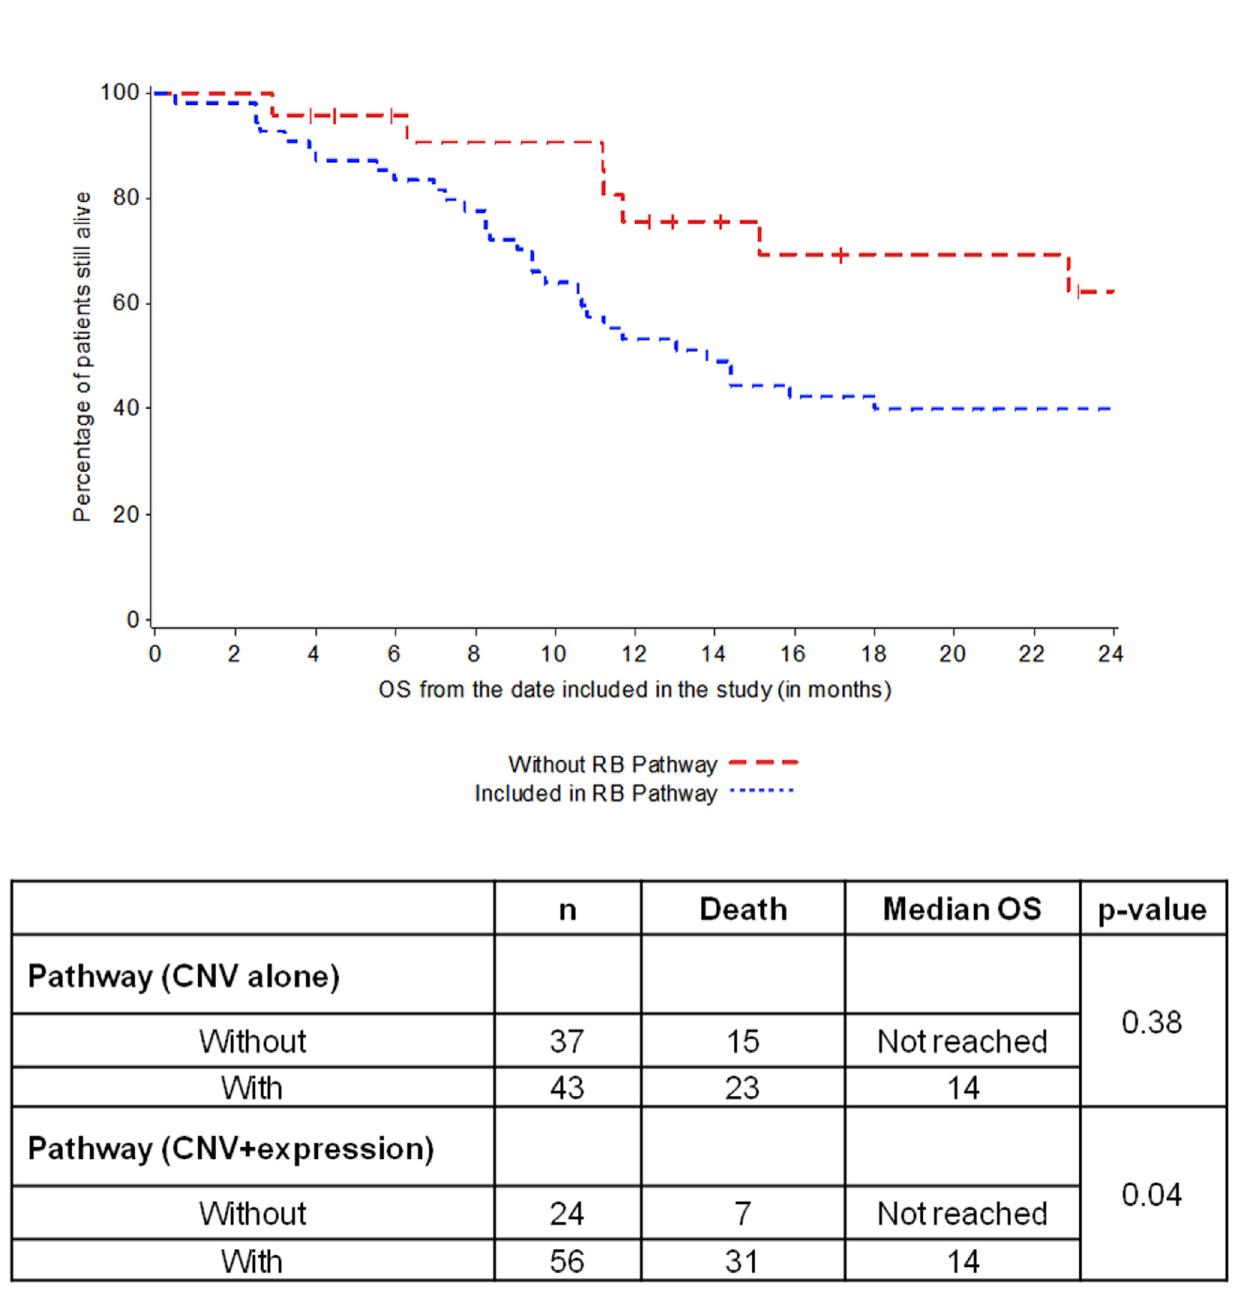
Fig 3. Association between RB1 pathway (CNV and expression) and